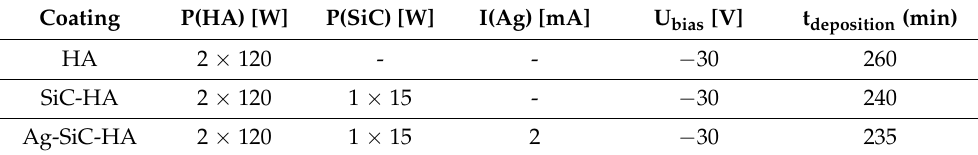
Table 1. Deposition parameters of the HA-based